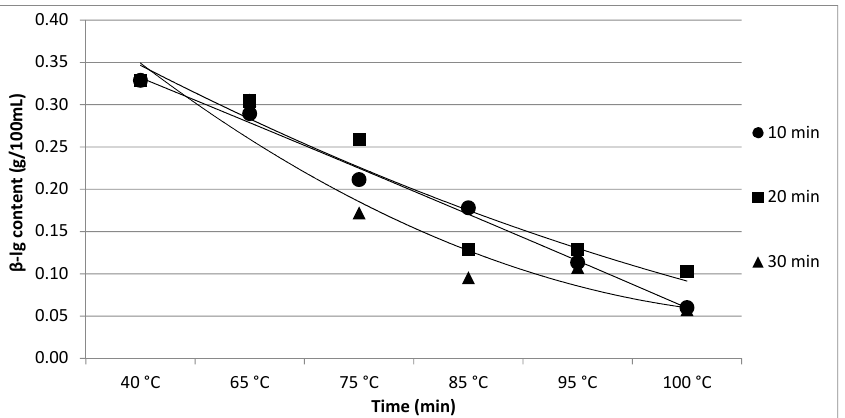
Figure 3. Effect of heating time and temperature on κ -cas content. Equations: 10 min (y = 0.001x 2 − 0.0281x + 0.3257; R 2 = 0.9307), 20 min (y = − 0.0048x 2 + 0.0077x + 0.2874; R 2 = 0,9956), 30 min (y = − 0.0139x 2 + 0.0371x + 0.2731; R 2 = 0.9768).